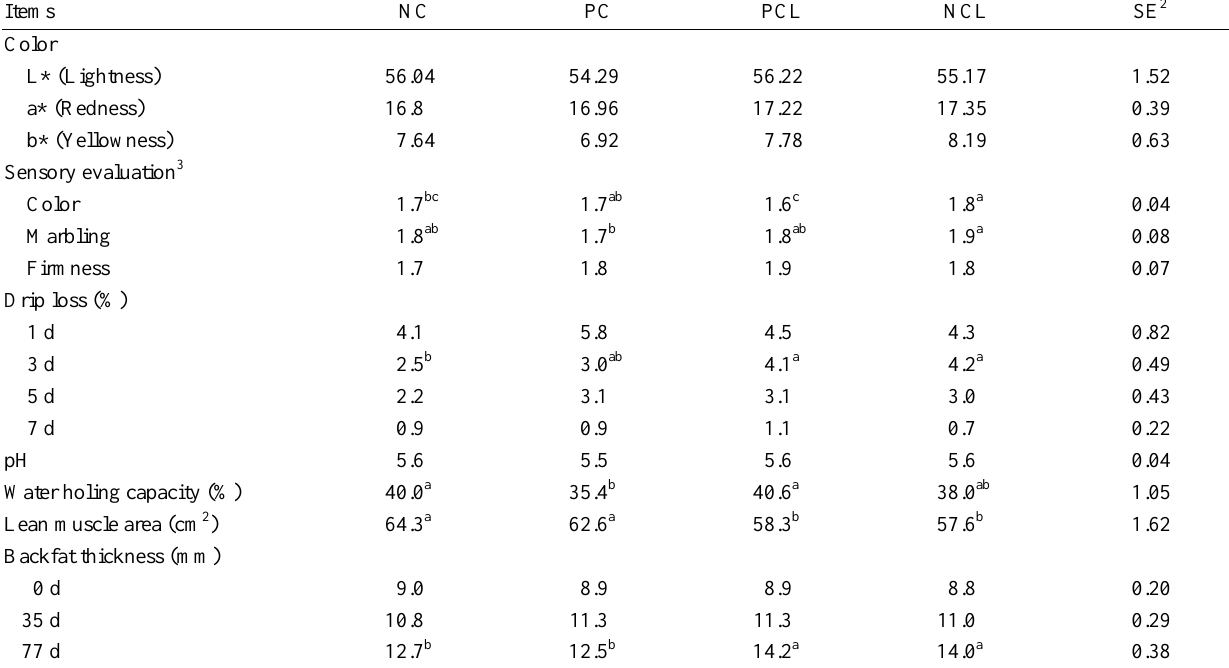
Table 5. Effect of low fermentable carbohydrates (FC) on meat quality of finishing pigs 1